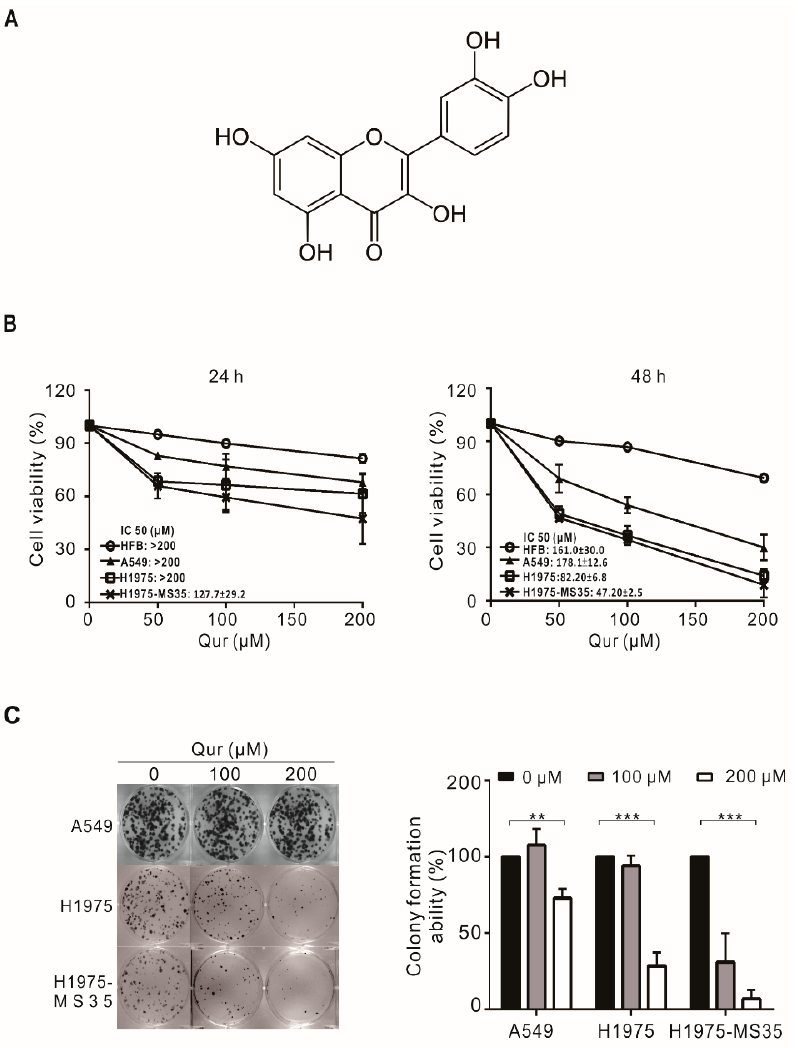
Figure 1. Effects of quercetin on the viability and clonogenic potential of NSCLC cells. ( A ) The chemical structure of quercetin. ( B ) NSCLC cells and normal human fibroblasts (HFBs) were treated with 0–200 μ M quercetin (Qur) for 24 or 48 h, and viability was determined with trypan blue assays. ( C ) NSCLC cells were treated with 0–200 μ M quercetin for 24 h and cultured for an additional 6 days in the absence of the drug. The colonies were counted and evaluated to determine the relative colony formation ability. The data are expressed as the mean ± SD of three independent experiments. Symbols: ** p < 0.01 and *** p < 0.001 as analyzed by One-Way ANOVA.